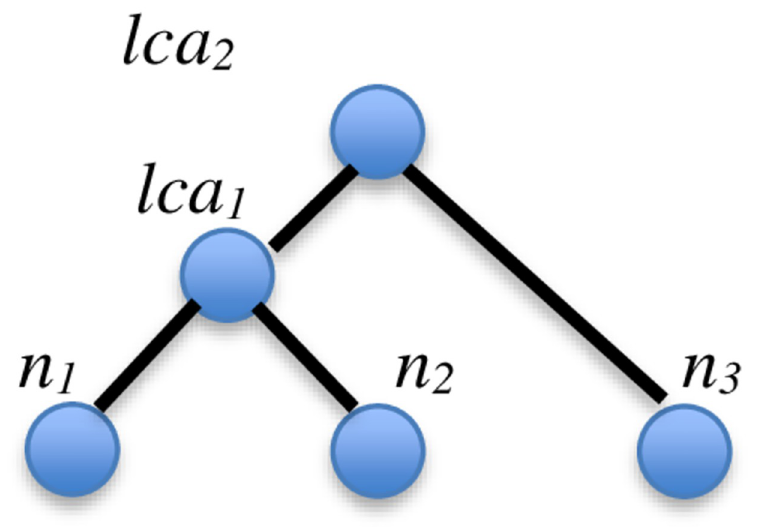
Fig 10. Illustration of the RLCA concept.